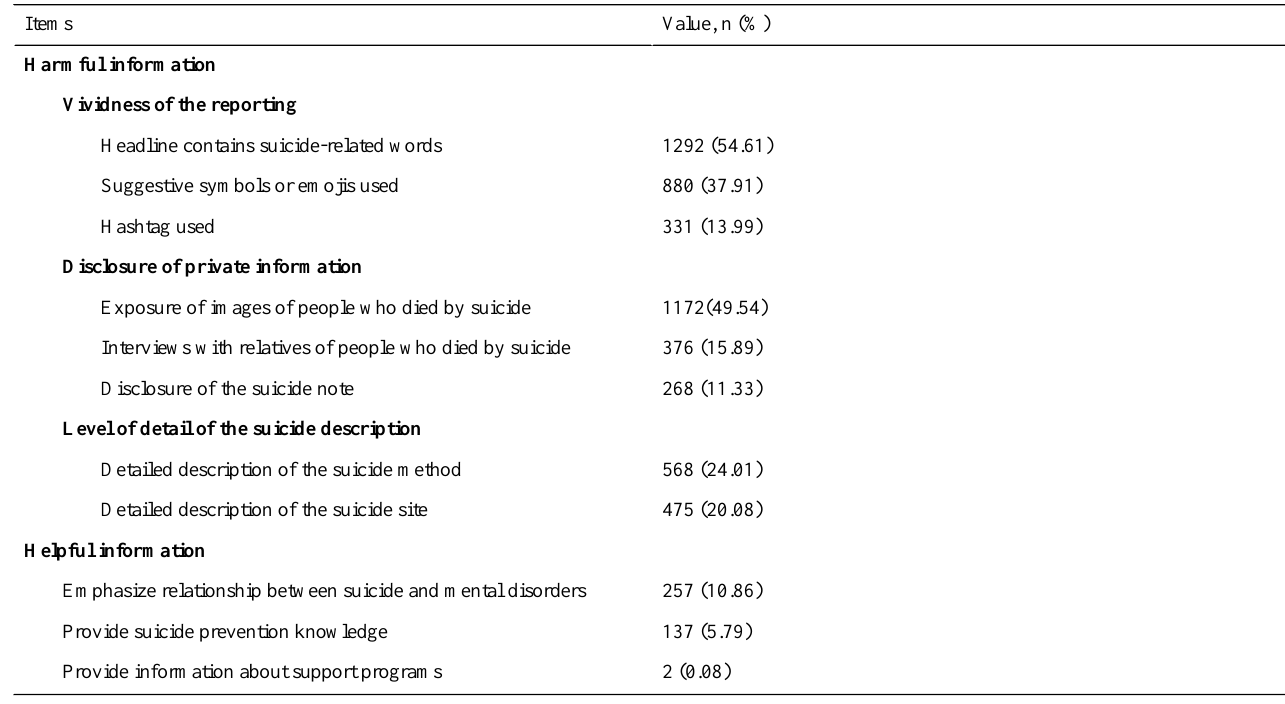
Table 4. Assessing suicide reporting quality on social media against the WHO guidelines